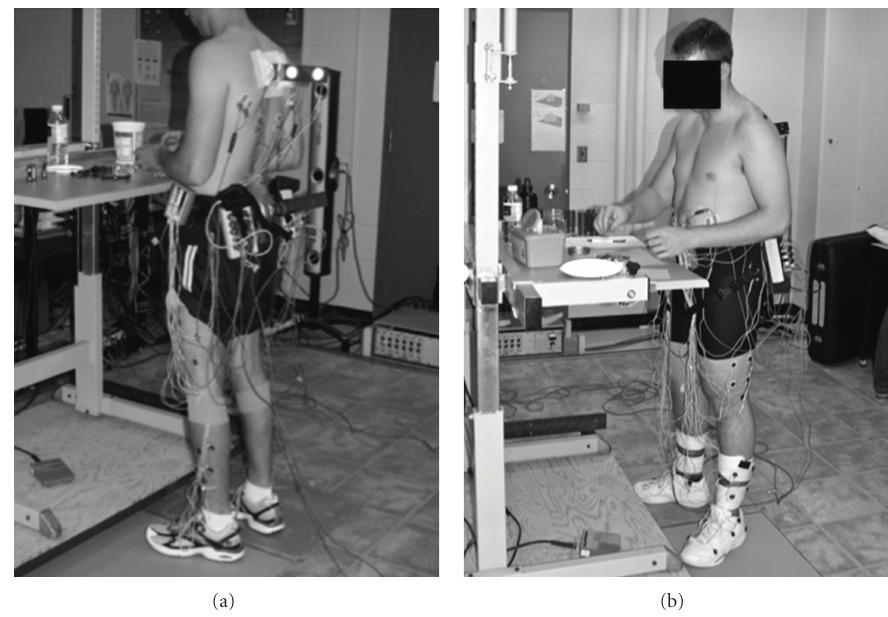
Figure 1: The experimental setup for the prolonged standing